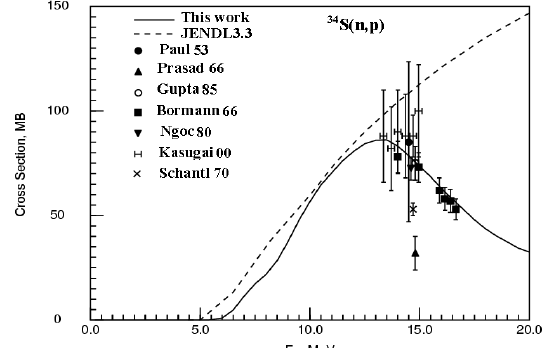
Fig. 10 . The comparison of CENDL-3.2 (solid line) and other evaluated (solid line) for 34 S (n, p) cross section and the available experimental data [13].